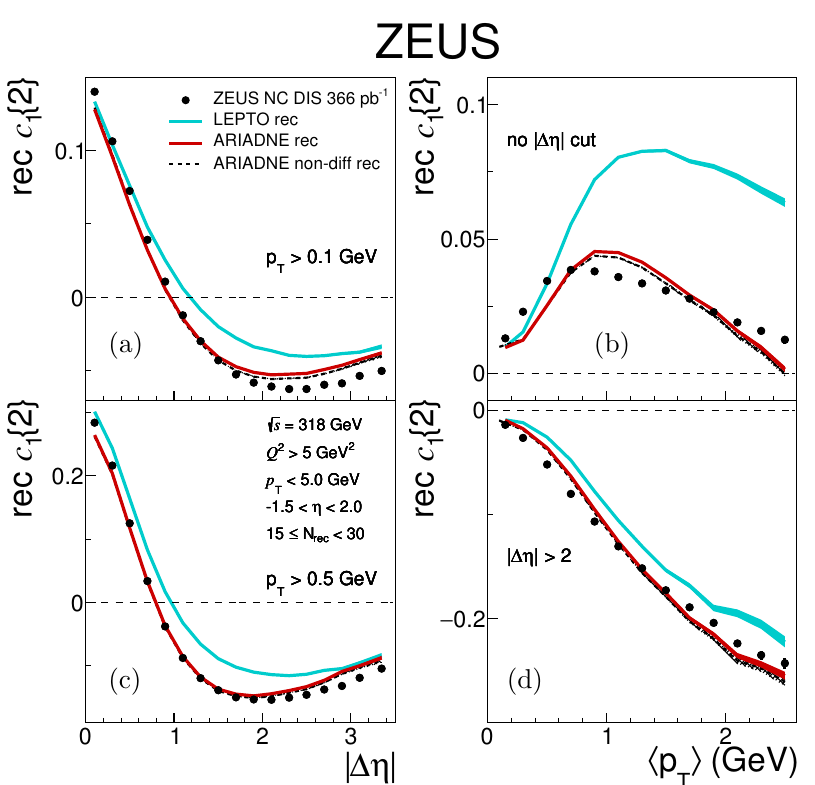
Figure 4 . Reconstructed c 1 f 2 g versus j (cid:1) (cid:17) j and h p T i . The (a) and (b) panels represent the kinematic intervals given by p T > 0 : 1 GeV and no j (cid:1) (cid:17) j cut. The (c) and (d) panels are further